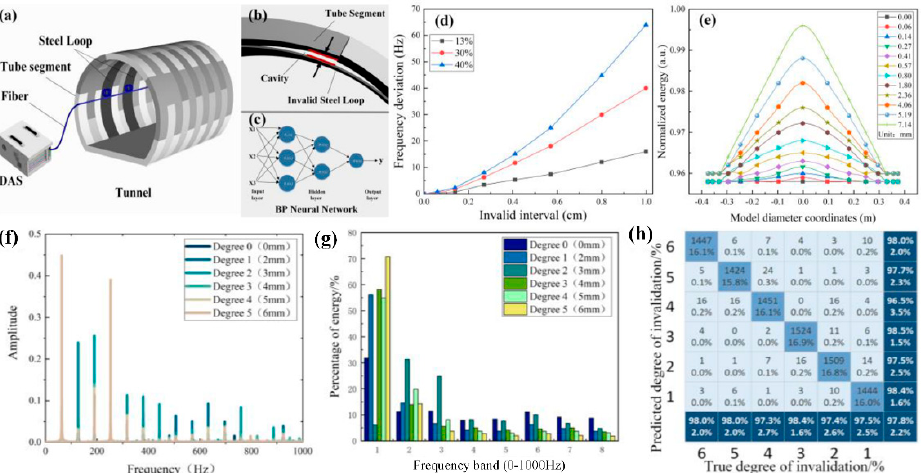
Figure 20. ( a ) Tunnel steel loop detection system based on DAS. ( b ) Schematic diagram of an invalid steel loop. ( c ) BP neural network. ( d ) Relationship between the degree of invalidity and the frequency deviation, ( e ) Relationship between the degree of invalidity and the energy distribution. ( f ) Power spectrum under different degrees of invalidity. ( g ) Wavelet energy transformation under different degrees of invalidity. ( h ) Recognition rate [81].